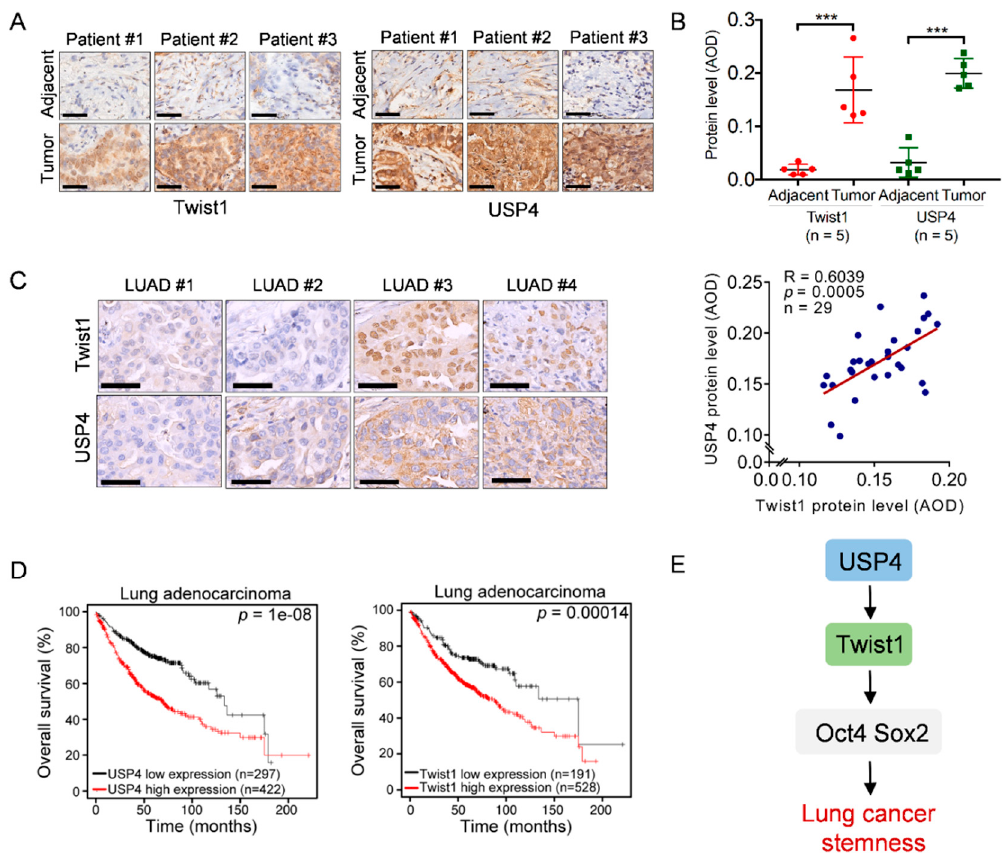
Figure 4. High expression of USP4 is positively correlated with Twist1 and associated with poor overall survival in human lung cancers. ( A , B ) Consecutive tissue slides derived from human lung adnocarcinoma (treatment-naïve) and adjacent normal tissues were subjected to immunohistochemistry (IHC) for expression of USP4 and Twist1 expression. Representative images of IHC staining were shown ( A ). Stainings were quantified by average optical density (AOD) ( B ). *** p < 0.001. Scale bar = 50 µ m. ( C ) Consecutive tissue microarray slides derived from human lung adenocarcinoma (LUAD) were subjected to IHC analyses for Pearson correlation of USP4 and Twist1 expression. Representative images of IHC staining were shown. Stainings were quantified by average optical density (AOD). Scale bar = 50 µ m. ( D ) Kaplan–Meier plots of overall survival of human lung cancer patients were stratified by the USP4 or Twist1 mRNA expression levels in the patient tumor samples. ( E ) A working model depicting that USP4 deubiquitinates and stabilizes Twist1 protein to promote lung cancer